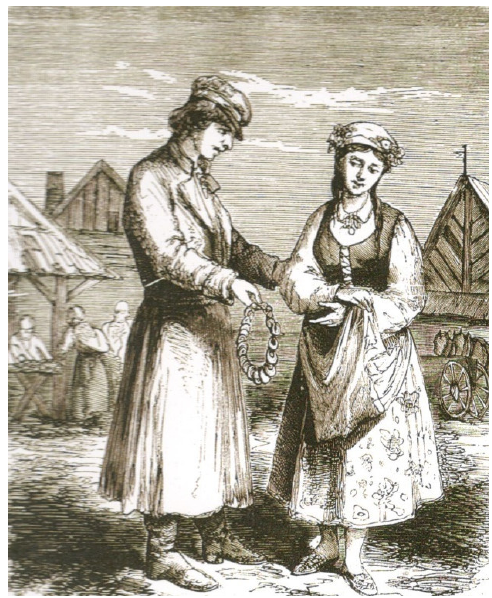
Figure 9. Young man gives the rolls to his girlfriend